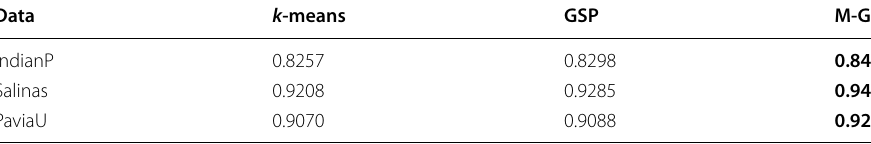
The best performances are marked in bold